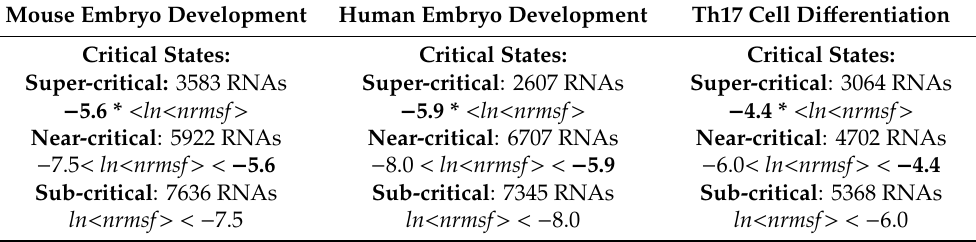
Figure 10. Systemic determination of local critical states for a cell population (microarray data). ( A ) In MCF-7 breast cancer cells, Sarle’s bimodality coe ffi cient ( b > 5 / 9: onset of bimodal profile) shows that around the CP, a unimodal-to-bimodal transition (from high to low nrmsf ) occurs for the group expression profile ( K = 30: n = 742 mRNAs), which reveals three distinct profiles (red: super-; blue: near-; purple: sub-critical state) in whole-genome expression (left: HRG stimulation; right: EGF stimulation). To confirm these distinct behaviors (see panels ( B ) and ( C )), which are based on the temporal response of the CM group (first column; refer to Figure 2), we examined the Euclidean (cid:16) (cid:17) > , ( k = 1, 2, ... , t j distance (second column) between two ensemble averages, < c k ( t = 0 ) > and < c k K = 25) from higher nrmsf , and confirmed three distinct behaviors with a boundary indicated by dashed vertical lines. Similarly, for HL-60 human leukemia cells, the corresponding results are shown for ( D ) atRA stimulation and ( E ) DMSO stimulation. In the third column ( B – E ), the corresponding region of critical states is shown in a histogram of gene expression according to ln ( nrmsf ). Note: The CP lies at the boundary between near- and sub-critical states, di ff erent from the case with a single cell (Figures 7–9). Table 1. Local critical states of single-cell genome expression. The boundaries of critical states with the number of RNAs are given for mouse (left column) and human (middle column) embryo development, and Th17 cell di ff erentiation (right column), where the bold black value corresponds to the ln < nrmsf > value of the CP. * CP exits at the boundary between the super- and near-critical states.